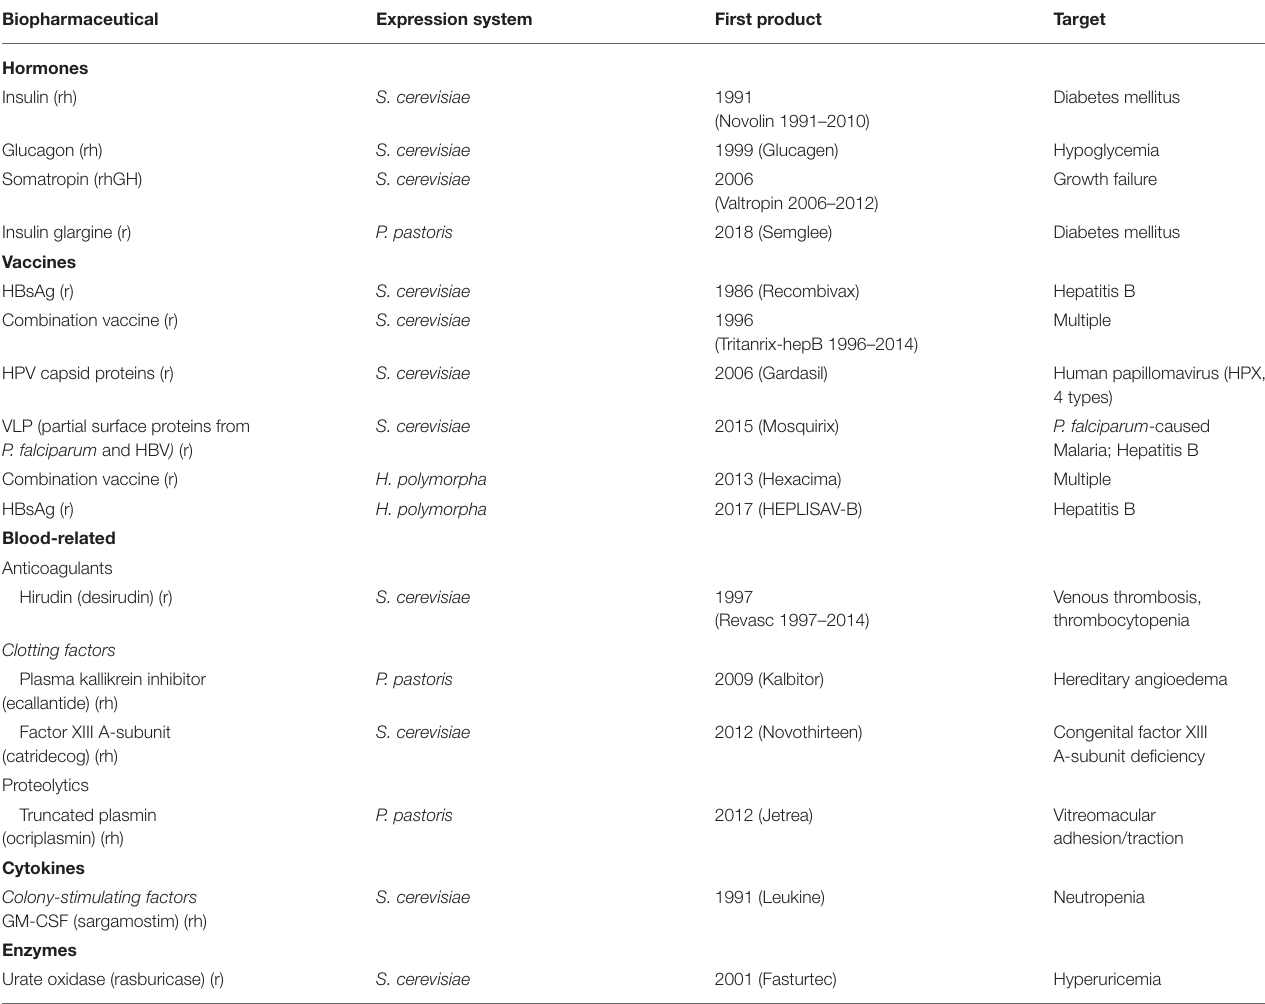
TABLE 1 | FDA-approved biopharmaceuticals produced in yeast cells (adapted from Walsh,